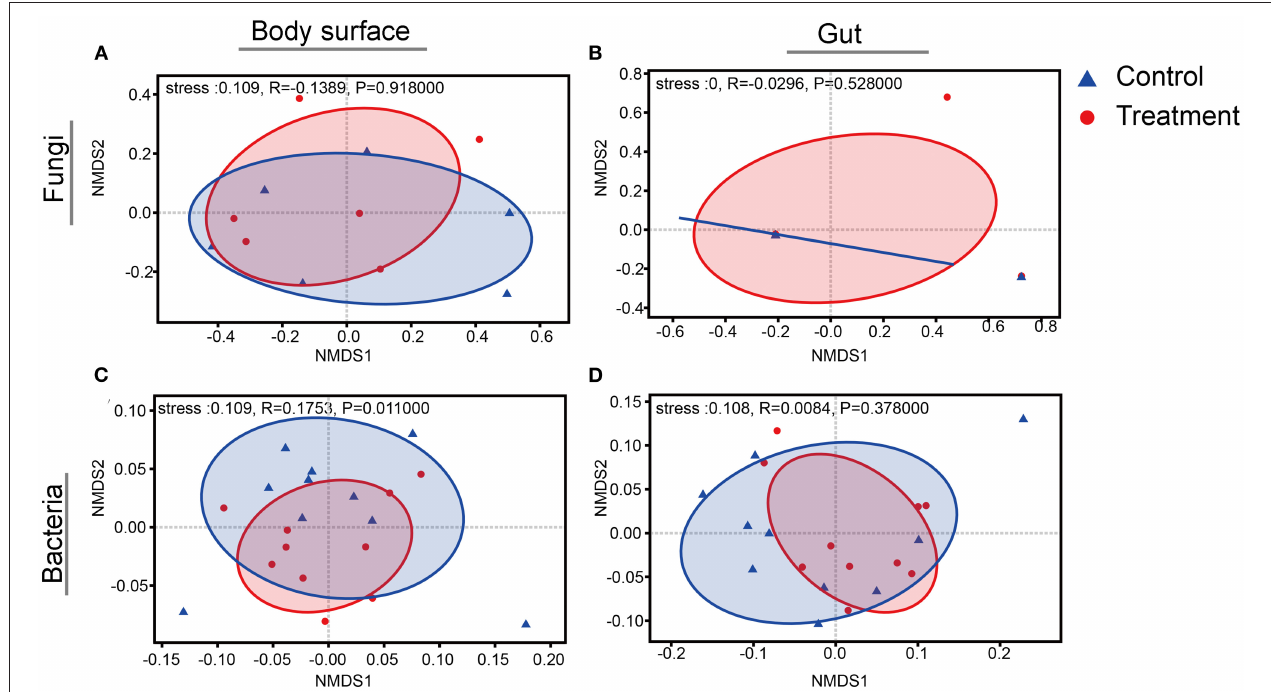
FIGURE 3 | Non-metric multidimensional scaling (NMDS) diagrams of body surface samples and gut samples for microbial community analysis. (A–D) NMDS diagrams of fungal body surface samples, fungal gut samples, bacterial body surface samples, and bacterial gut samples, respectively. NMDS diagrams are based on a Bray–Curtis distance matrix for microbial communities that consisted of operational taxonomic units (OTUs) (97% similarity level). Blue triangles represent body surface or gut samples treated by PBS (control), and red dots represent samples treated by B. bassiana . Significance values refer to analysis of similarity (ANOSIM, p < 0.05) test for differences in community composition between the control group and the B. bassiana -treated